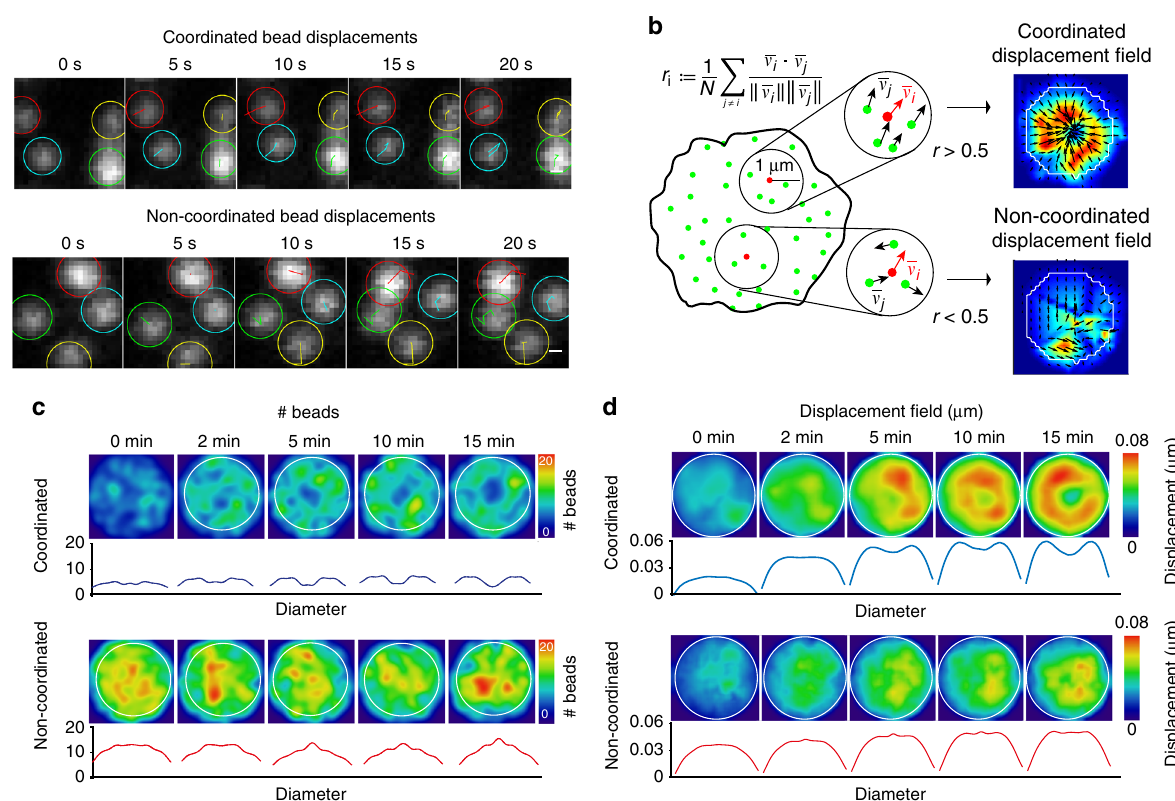
Fig. 2 Forces at the synapse exhibit two components. a Time-lapse images of individual beads showing displacement tracks in coordinated and non- coordinated type of movements, scale bar is 0.3 µ m. b Scheme showing the method used to separate the bead population in two pools, allowing extraction of coordinated and non-coordinated displacements. c Mean bead distribution in coordinated and non-coordinated pool of stress ( n = 100 cells). Below: radial pro fi le of the density map obtained by average spatial distribution of the beads by resizing all cells and interpolating each bead with a Gaussian kernel. d Mean displacement fi eld map obtained by resizing and averaging (over all cells) at the indicated time point the individuals coordinated and non- coordinated stress